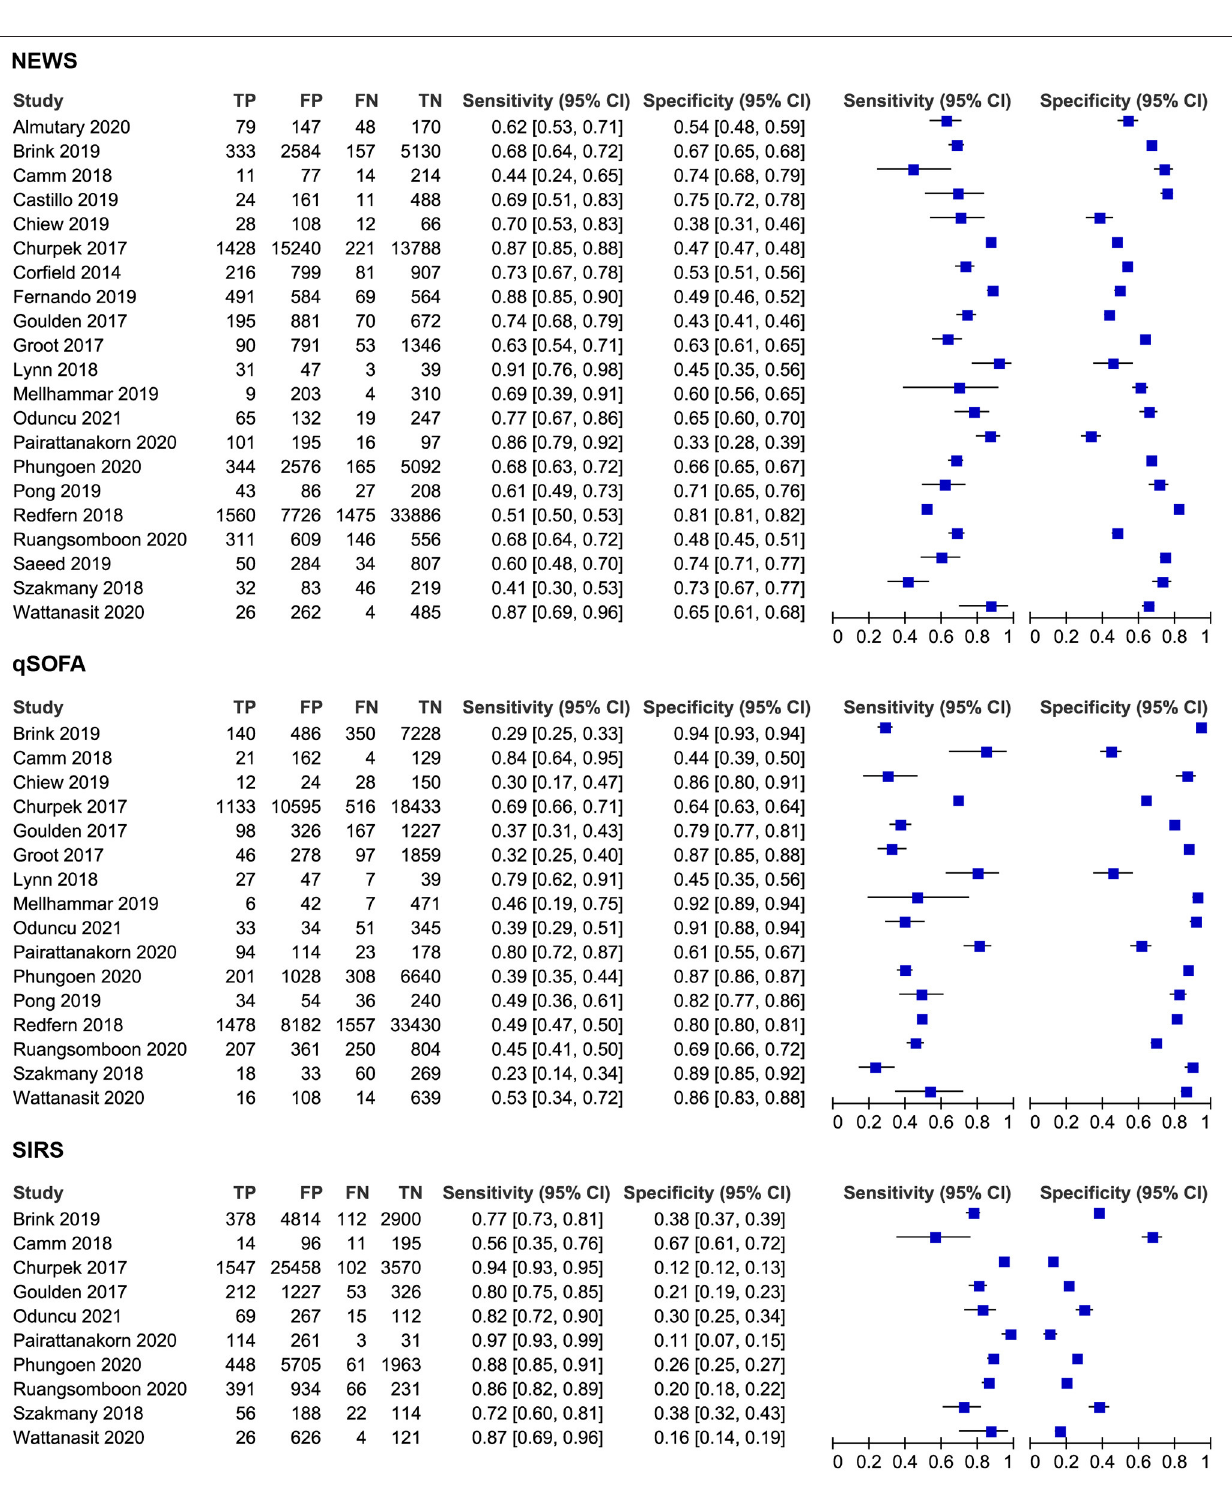
FIGURE 2 | Forest plots of sensitivity and specificity for NEWS, qSOFA and